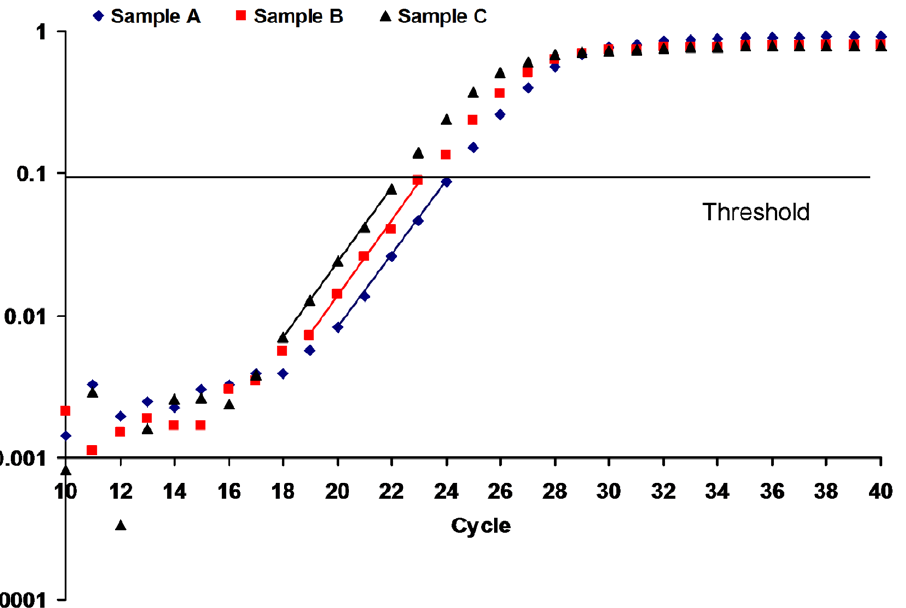
Figure 1. Effects of standard DNA addition on fluorescence intensity and C t . Oblique lines: exponential amplification phases suggested by LinRegPCR; Sample A: with 1 m l of tomato genomic DNA (10.20 ng m l 2 1 , containing 10,000 ELIP molecules m l 2 1 ) as PCR template; Sample B: with 1 m l tomato genomic DNA plus 1 m l of pHE (0.051 pg m l 2 1 , containing 10,000 ELIP molecules m l 2 1 ) as PCR template; Sample C: with 1 m l tomato genomic DNA plus 3 m l of pHE as PCR template.